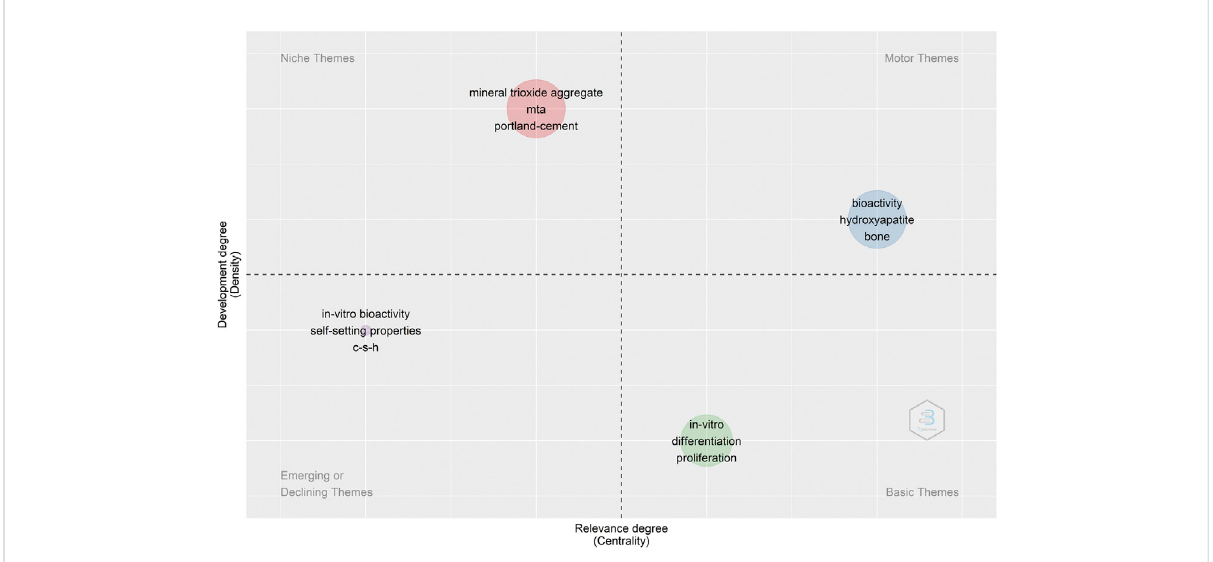
FIGURE 8 ThematicmapofKeywordsPlus.TheXaxisrepresentsthecentrality(i.e.,thedegreeofinteractionofanetworkclusterincomparisonwithother clusters) and gives information about the importance of a theme. The Y axis symbolizes the density (i.e., measures the internal strength of a cluster network, and it can be assumed as a measure of the theme ’ s